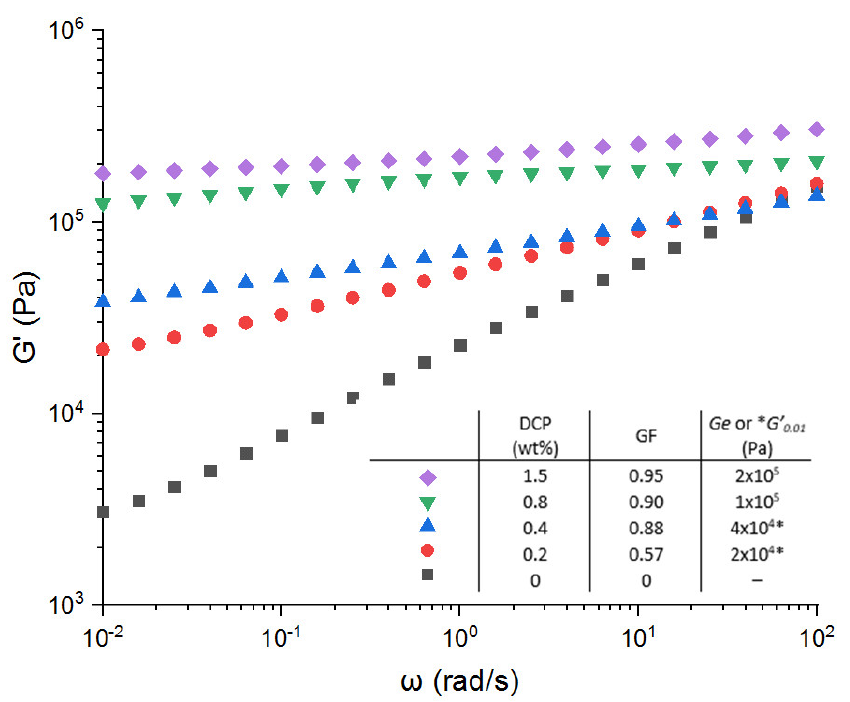
Figure 1. Variation of the storage modulus versus angular frequency for the EPDM-g-MA crosslinked with different peroxide concentration (wt.%). No metallic salt has been added in these formulations.* is G ′ 0 . 01 reported instead of Ge.